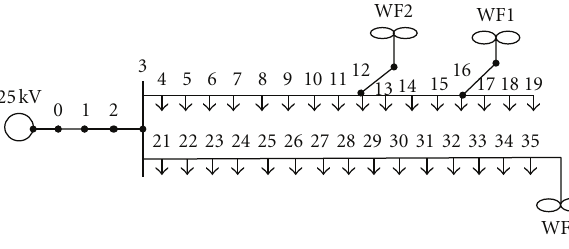
Figure 6: 25 kV weak distribution